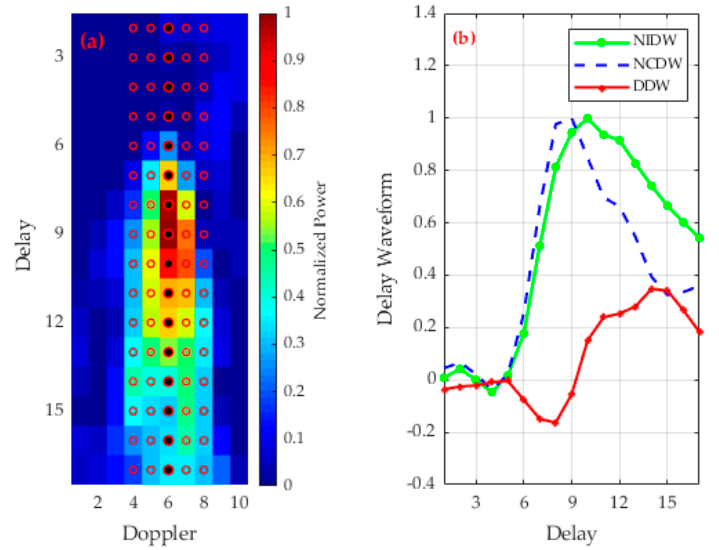
Figure 4. Denoised and normalized DDM and its delay waveforms. ( a ) DDM, the red hollow circle represents the time-delay row and Doppler column used for NIDW calculation during data filtering, and the black solid dot represents the NCDW (Doppler = 0 Hz). ( b ) represents the NIDW, NCDW, and DDW corresponding to DDM.